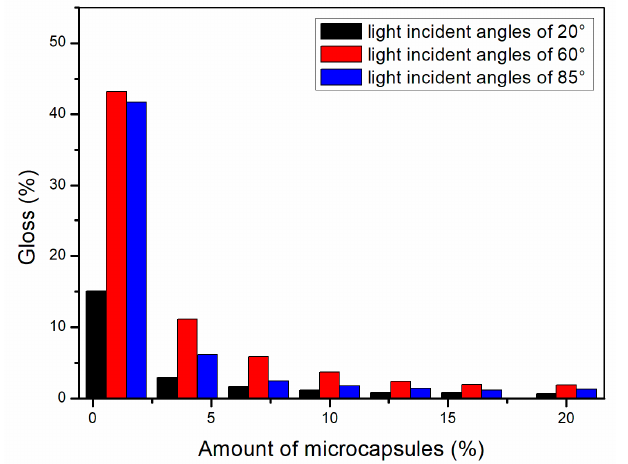
Figure 3. Effect of microcapsule content with the ratio of core materials to shell material in mass of 0.65 on gloss of coating film.